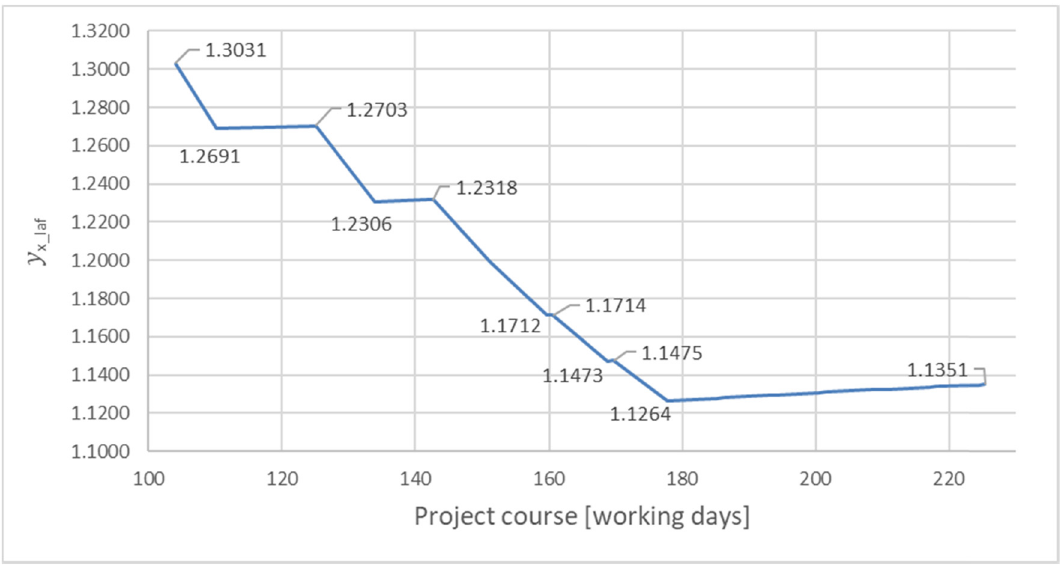
for workers with little experience in respect to soil strengthening variant x laf